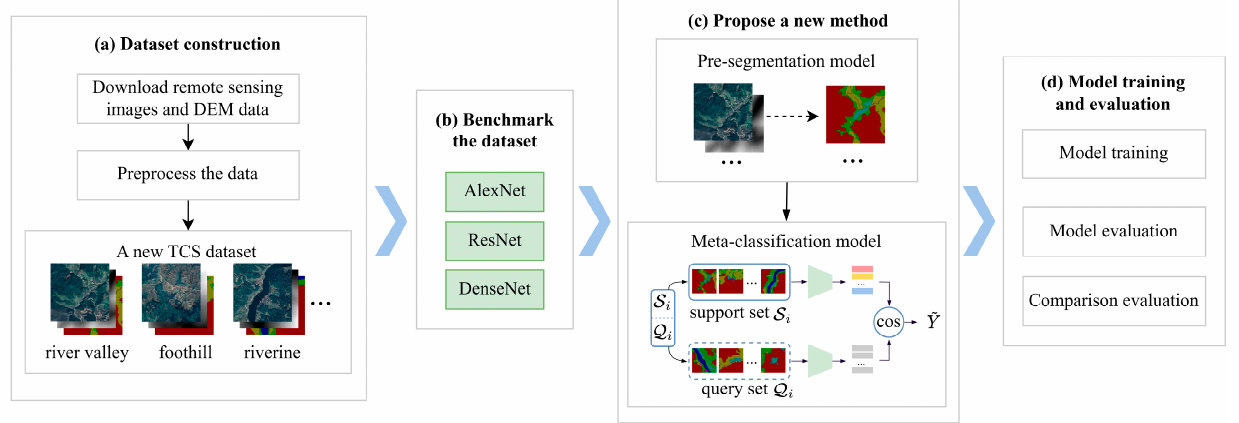
Figure 1. The workflow of the proposed method, which has four major components: ( a ) dataset construction; ( b ) benchmarking the dataset; ( c ) proposing a new method; ( d ) model training and evaluation.